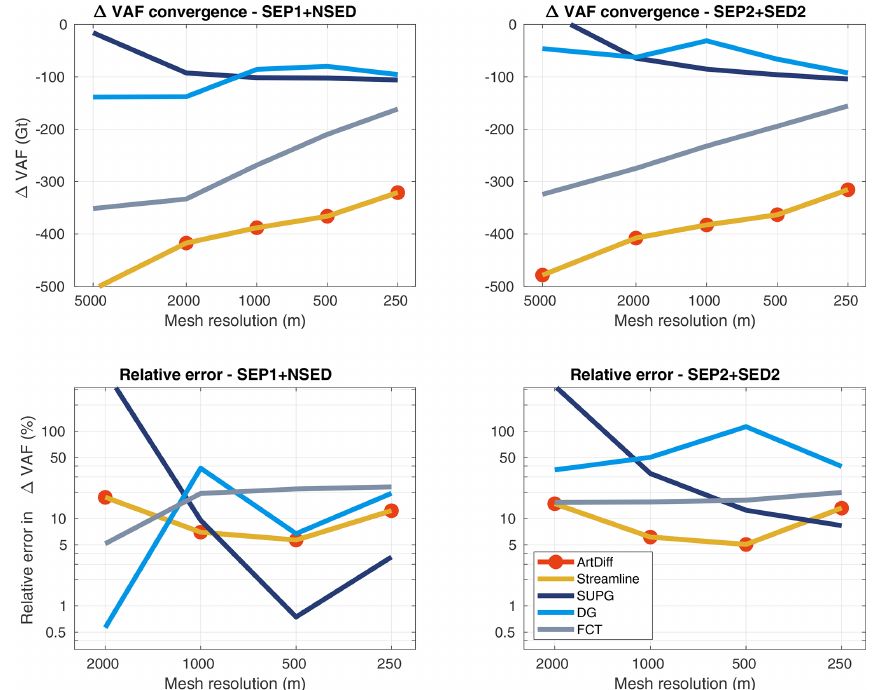
Figure 8. Basal melt experiment (no melt on partly floating elements): convergence of (cid:49) VAF at the end of the experiment ( t = 100 years) for different stabilization schemes (see legend). Two sets of sub-element parameterizations are employed: SEP1 + NSED (left panels) and SEP2 + SED2 (right panels). The relative errors are computed using Eq.